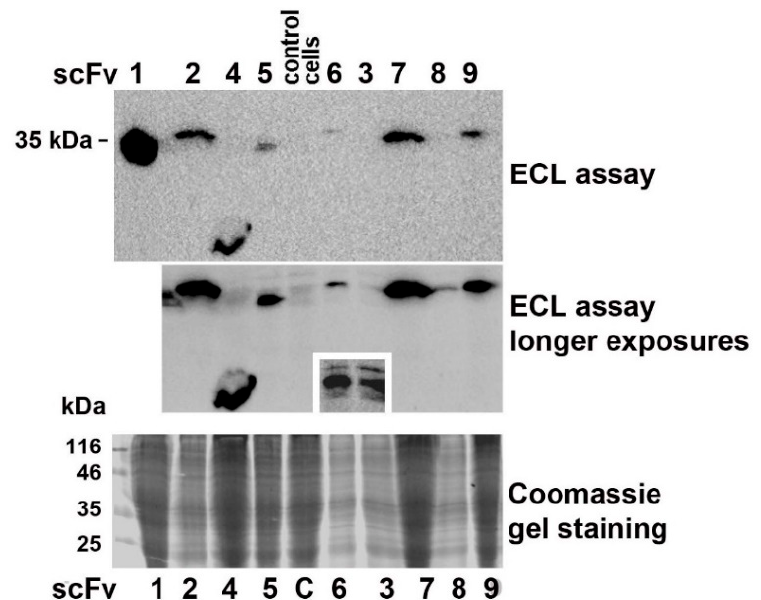
To express nine different Nb AAC1-specific scFv fragments in insect cells, their genes were cloned into the pIB/V5-His plasmid. Lipofection of Lepidopteran Sf9 cultures with engineered plasmids followed by selection of transformants in the presence of the antibi- otic blasticidin S and immunoblotting with anti-c-myc Abs demonstrated heterologous expression of cloned genes in insect cells (Figure 4). To correlate scFv accumulation in the transformants with the total protein concentrations in the samples, we repeated SDS-PAGE with the same aliquots and stained the gel with Coomassie. Since the lowest content of scFv 3, 6 and 8 in transformants correlated with lower protein concentrations in these samples, this generally indicates efficient expression of recombinant Abs in Sf9 cells. At the same time, the studied scFv fragments were differently expressed in the blasticidin-selected transformants, and the concentration of scFv1 significantly exceeded the content of other recombinant Abs. The single VH domain scFv4 showed the smallest molecular weight. The fragments scFv1 and 5 carrying VL part of a human IgG from the pSEX81 phagemid were also smaller than the other Abs.